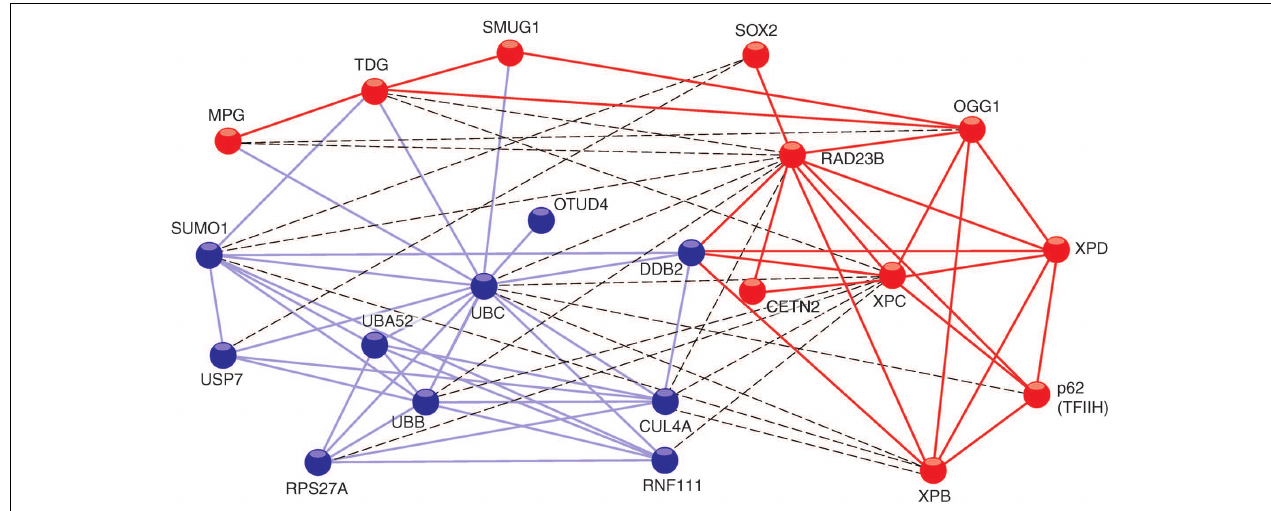
FIGURE 1 | STRING network view of XPC interactions with proteins. The connecting lines indicate proven or predicted interactions using the http://www.string-db.org information source. The different colors of the protein nodes reflect their clustering in two groups according to the KMEANS algorithm (Brohée and Helden, 2006). Blue nodes, ubiquitin-related proteins; red nodes, DNA repair proteins. Blue lines, interactions between ubiquitin-related proteins; red lines, interactions between DNA repair proteins. The dashed lines highlight interactions between the two different